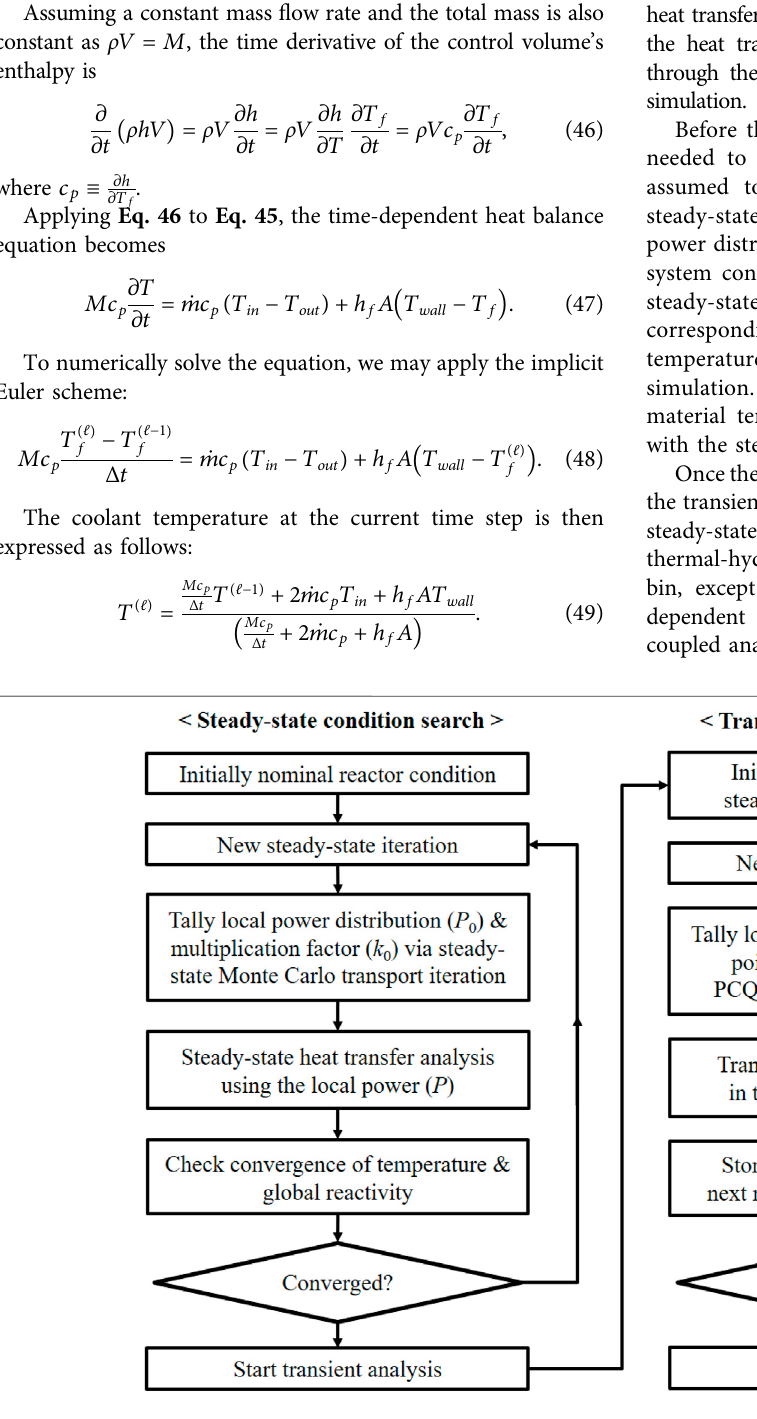
FIGURE 2 | Flowchart of coupled analysis